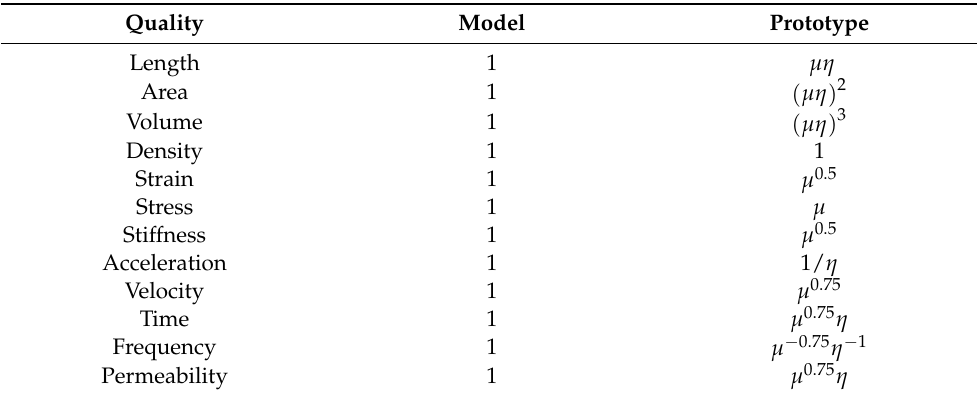
Table 2. Scaling factors of centrifuge modeling.